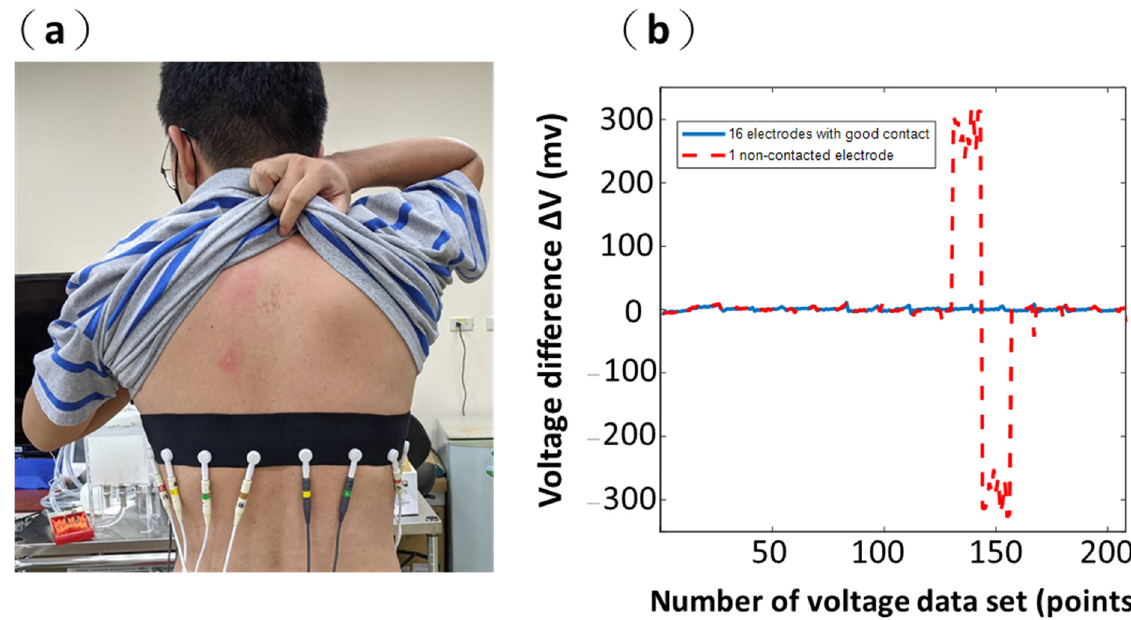
Figure 6. A in vivo is used to calculate the voltage difference ∆ V. ( a ) The wearable textile-electrode belt. ( b ) The voltage difference ∆ V with all 16 electrodes having a good contact and 1 non-contacted electrode.